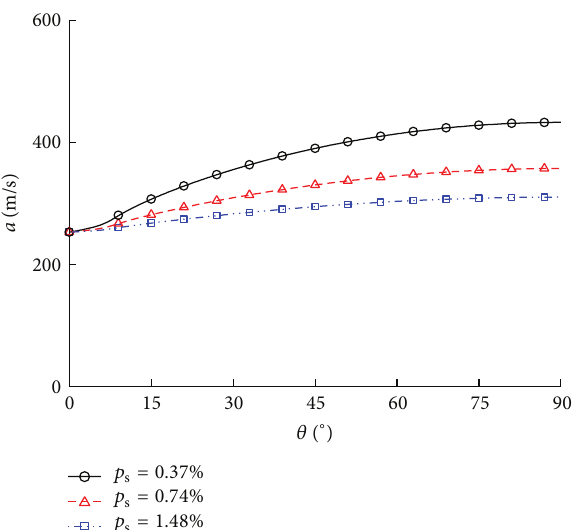
Figure 8: Influence of spiral winding angle on the wave speed.